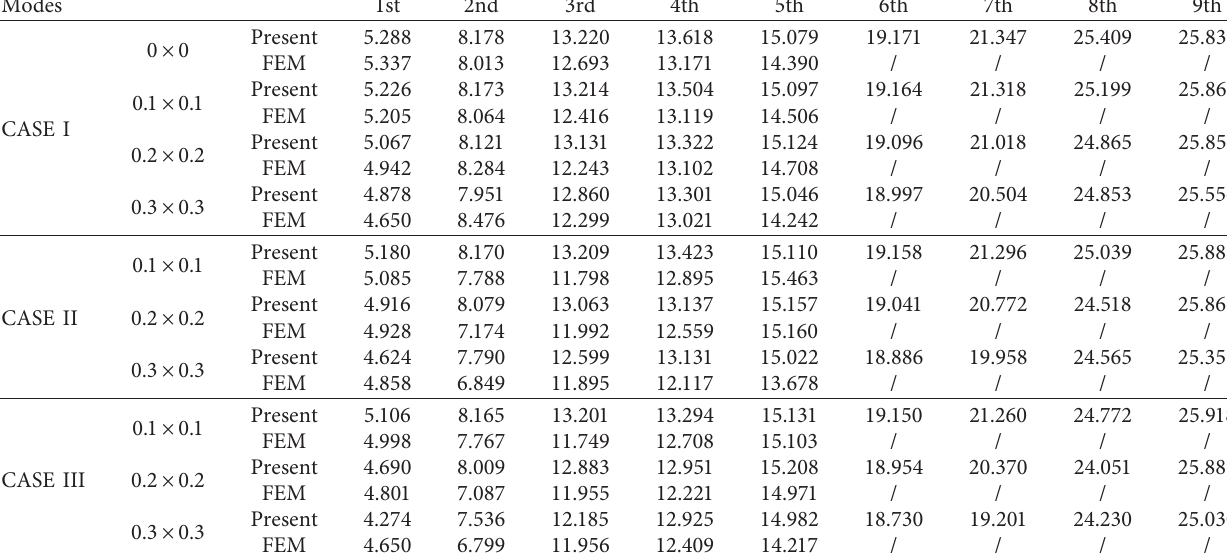
Table 1: Nondimensional frequencies of the cross-ply laminate ([0/90]s) with CCCC boundary condition, E 1/ E 2 � 10, and a � b � 10h and for different patch sizes and